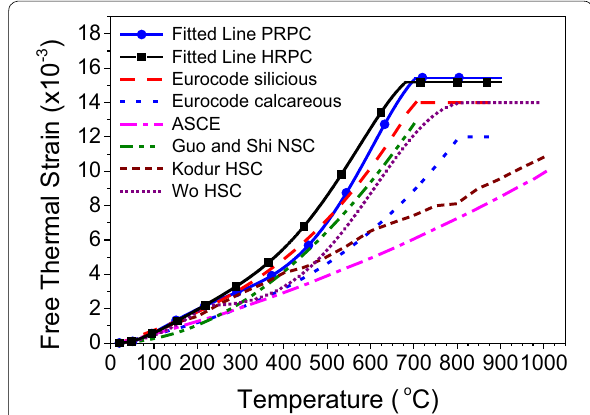
Fig. 12 Comparison of FTS with NSC, HSC and design codes.